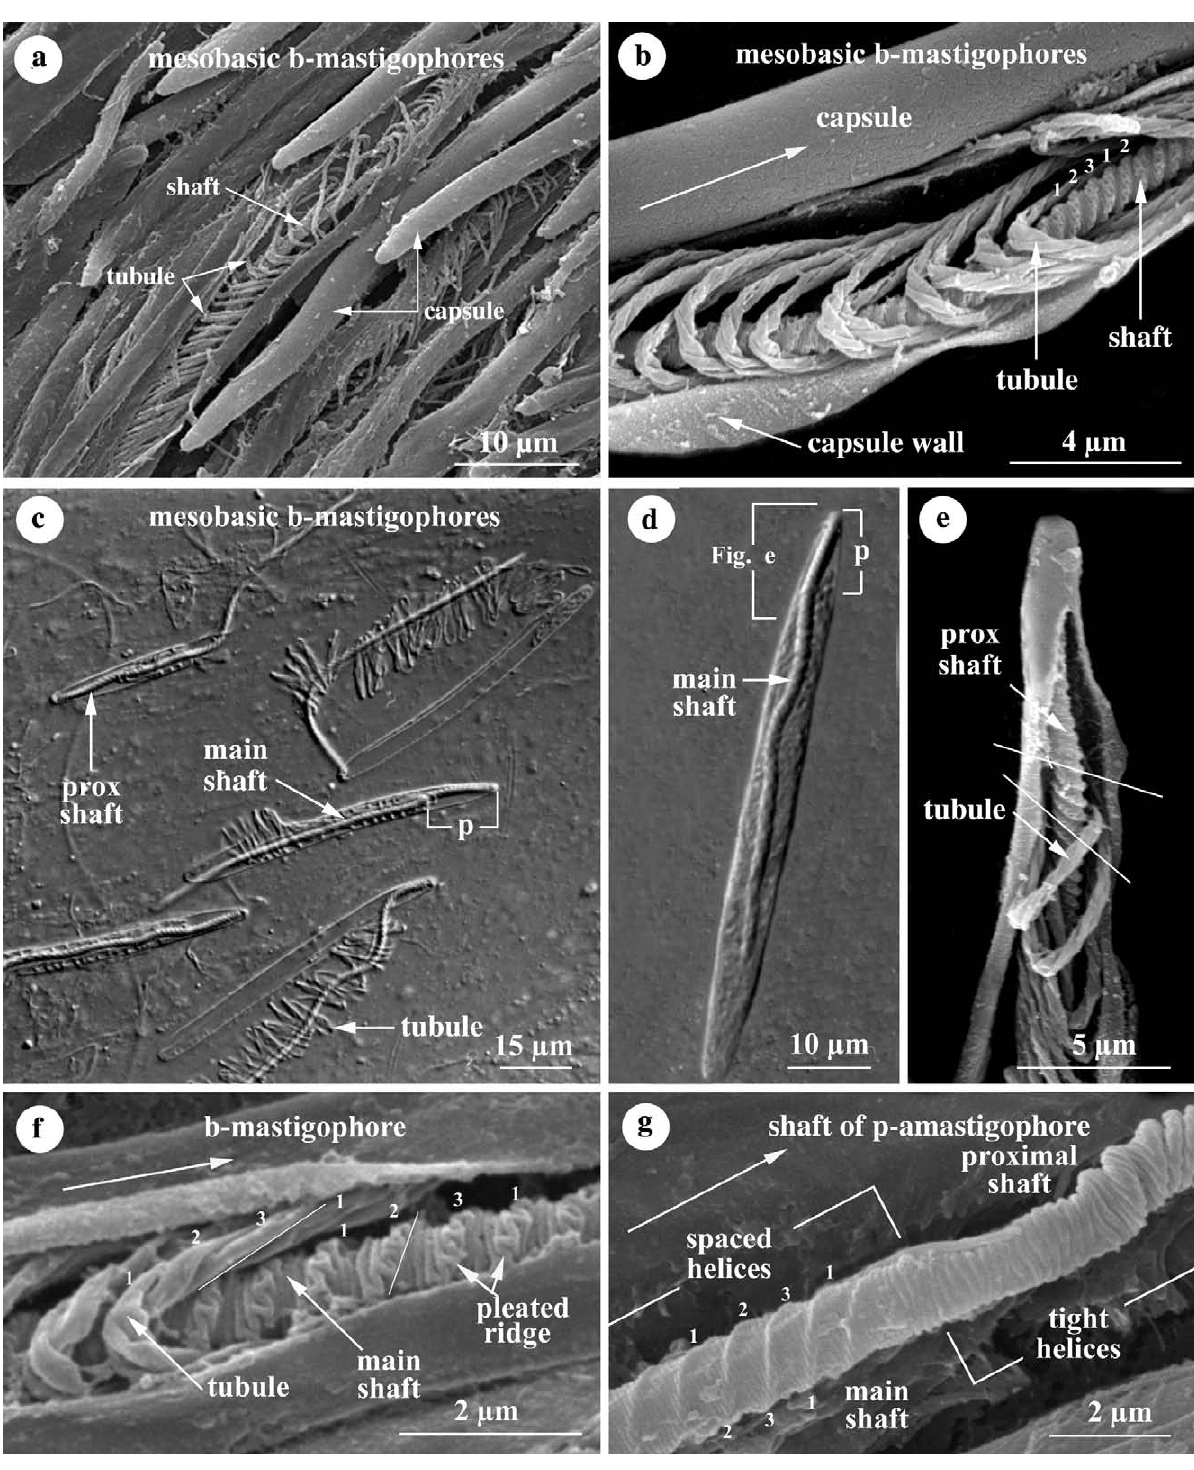
Fig . 5. – Intact and broken capsules of acontia nematocysts. a-f) Mesobasic b-mastigophores, large (as Fig. 1), and g) a p-amastigophore, large (as Fig. 2). a,b) Broken capsules showing shaft and tubule (SEM). b) Note helical folding of shaft and tubule. c) 4 broken capsules (1 intact). Their shafts and tubules have elongated without everting. Proximal shaft (p) straight. d) Intact capsule showing proximal and main shaft. e) Apical portion of a broken capsule (SEM). Helical folds of shaft wall appear to change pitch towards proximal shaft. f) Broken capsule showing helical folds on shaft and tubule walls (SEM). On the shaft these appear as pleated ridges. Lines show different pitches of shaft and tubule helices. g) Shaft of a p-amastigophore towards capsule apex (SEM). Proximal shaft with tight helices (has sparse spines), main shaft with spaced helices (has dense spines) (see Fig. 2c-e). Long arrows show direction of eversion; p , prox , proximal shaft; thin white lines show pitch of helices on shaft and tubule; 1,2,3, correspond to the 3 spines-rows on everted shaft (b,f,g) and tubule